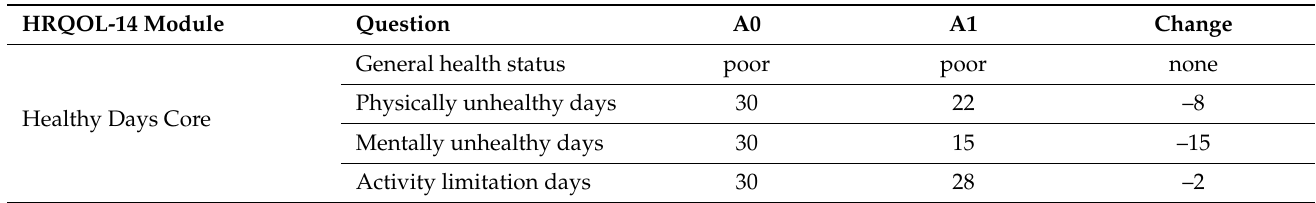
Table 5. Health-related quality-of-life assessment using HRQOL-14 scale before and after